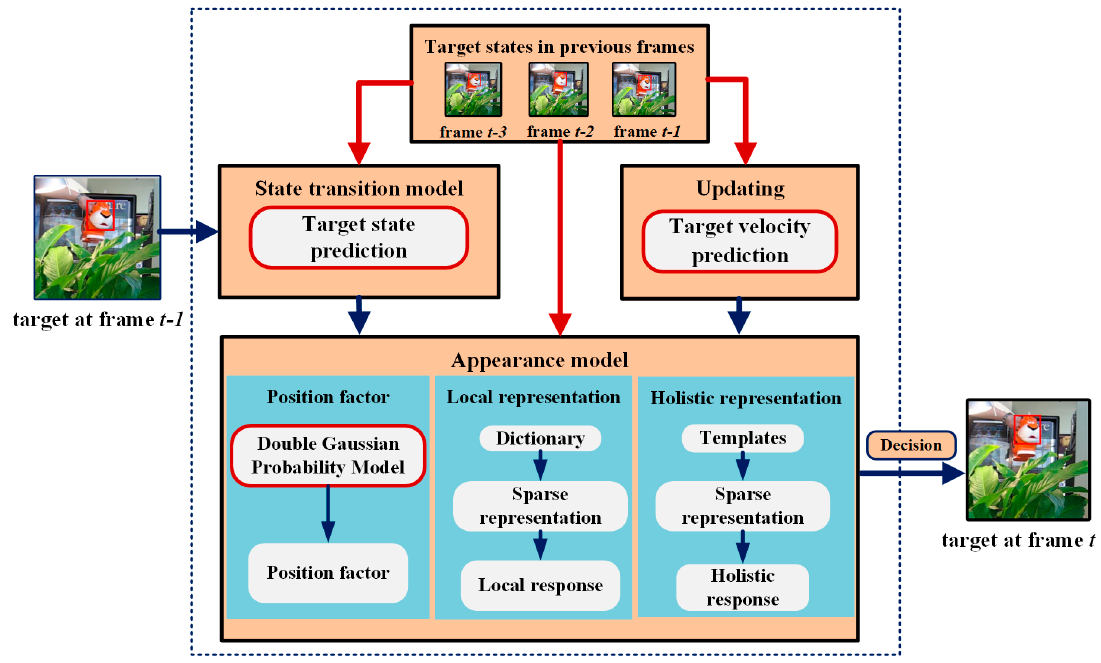
Figure 1. The candidates are predicted by the target state prediction based state transition model. In appearance model, the position factor is proposed to characterize the importance of candidate samples in different positions. In the target velocity prediction based updating model, the template sets are updated adaptively to ensure the robustness and effectiveness of MCT algorithm.